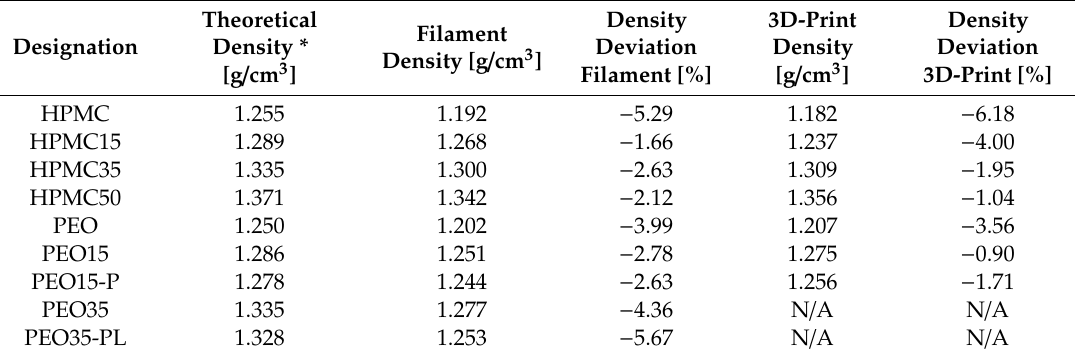
Table 4. Development of true densities along the process chain (He-pycnometer) with deviation from theoretical density of formulations.